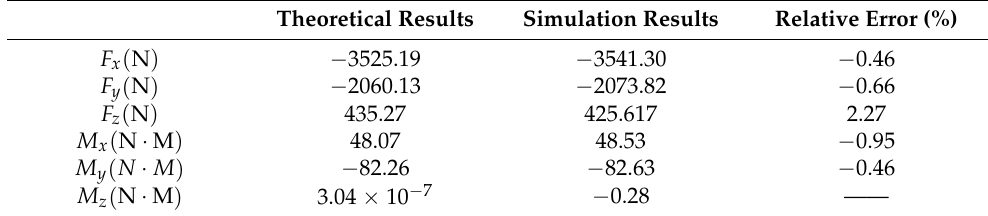
Table 1. The boundary force F f of the theoretical statics results and FEA simulation